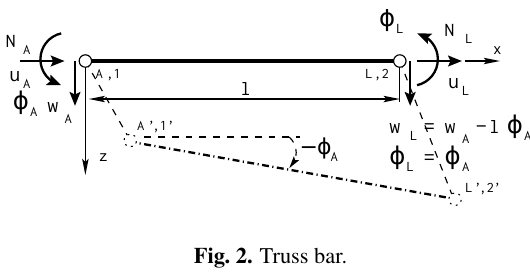
Fig. 2. Truss bar.